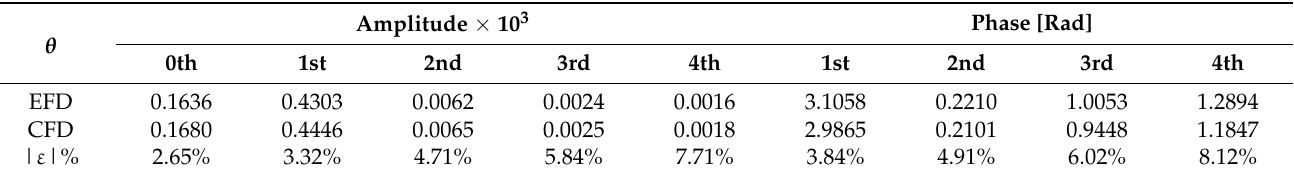
Table 8. Harmonic amplitudes and phases of pitch ( θ ) for the FRxz ϕθ head waves